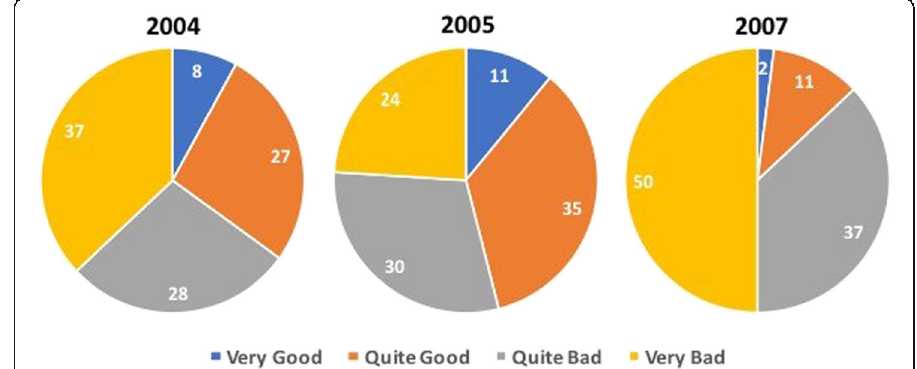
Fig. 3 Perception of Iraqi population on the status of electricity supply from 2004 to 2007 (D3 Systems